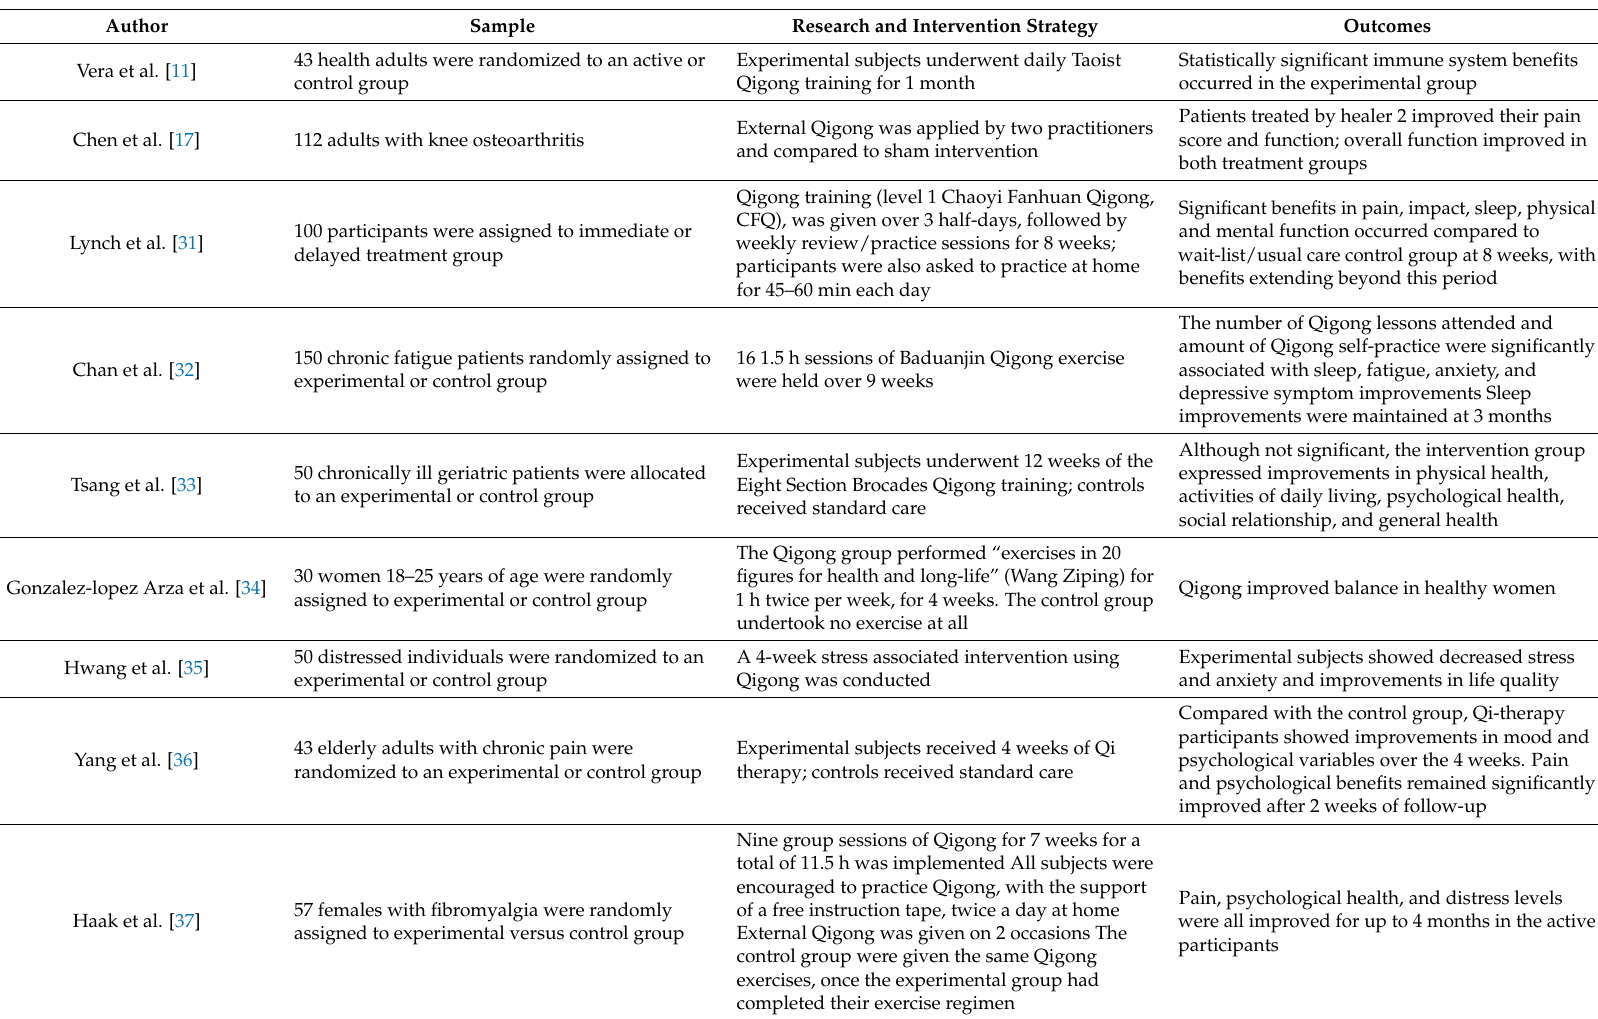
Table 2. Sample of Randomized Studies and Outcomes of Possible Relevance to